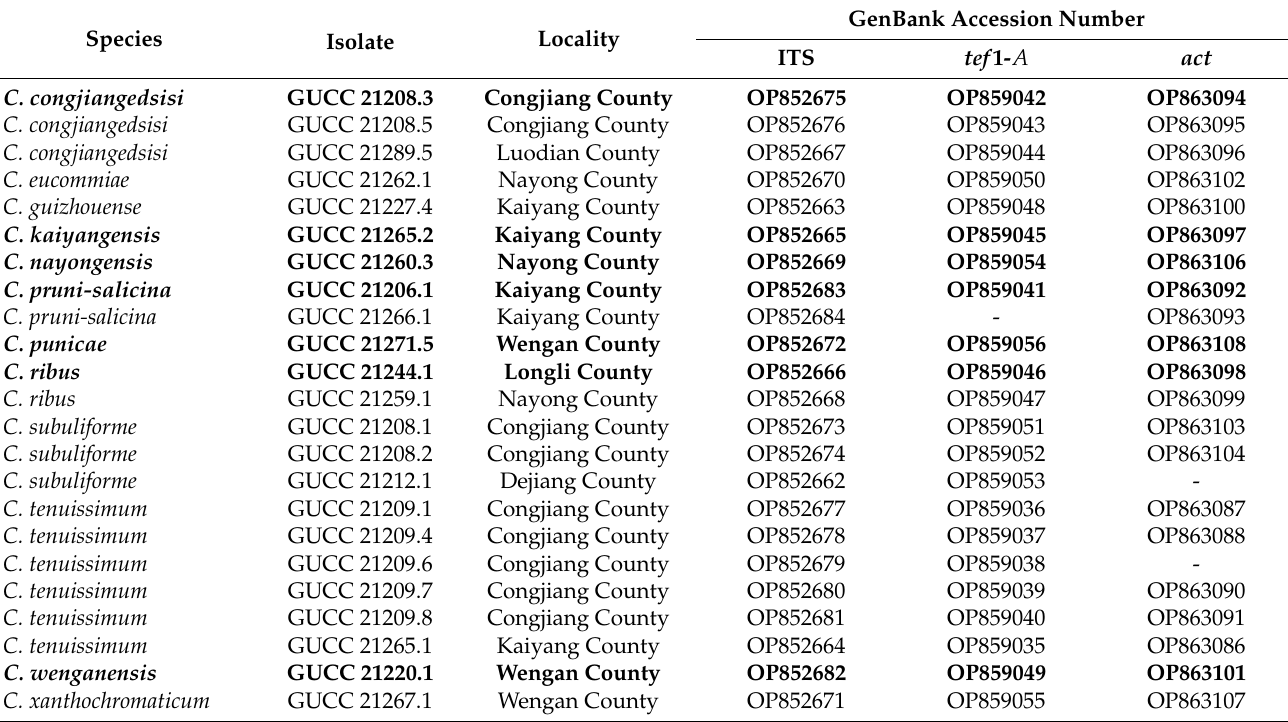
Table 1. Cladosporium species studied from Guizhou Province, China with GenBank numbers. Ex-type species are in bold.